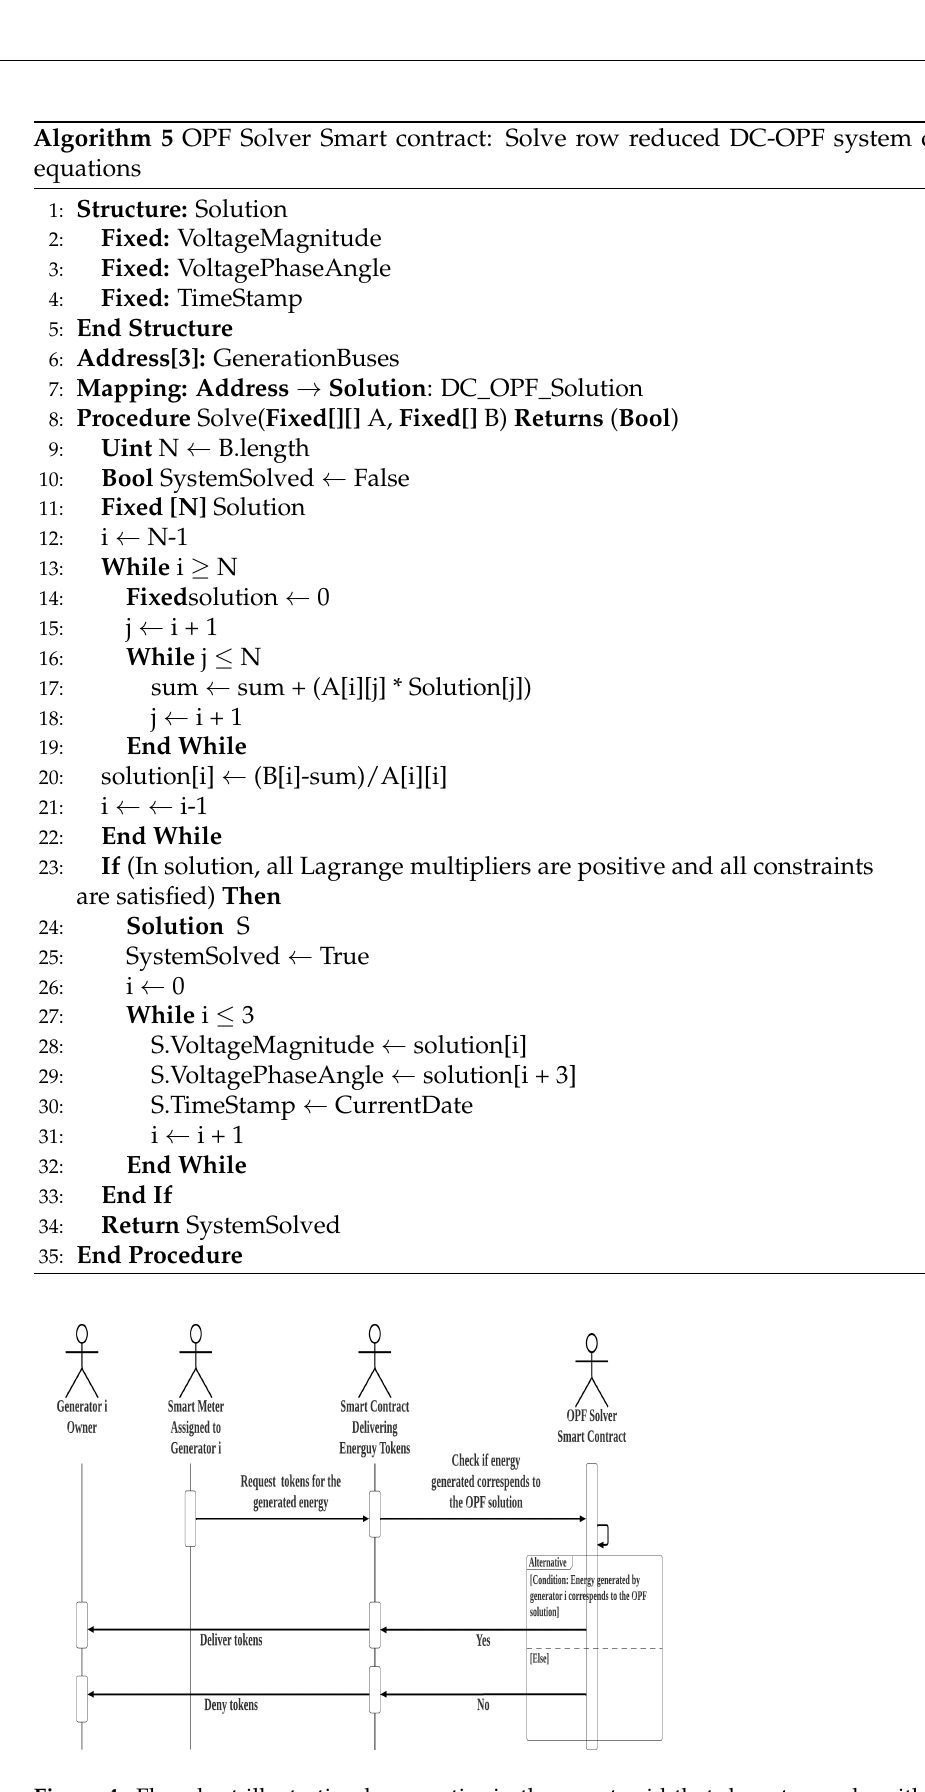
Figure 4. Flowchart illustrating how parties in the smart grid that do not comply with the OPF solution are not rewarded for their energy